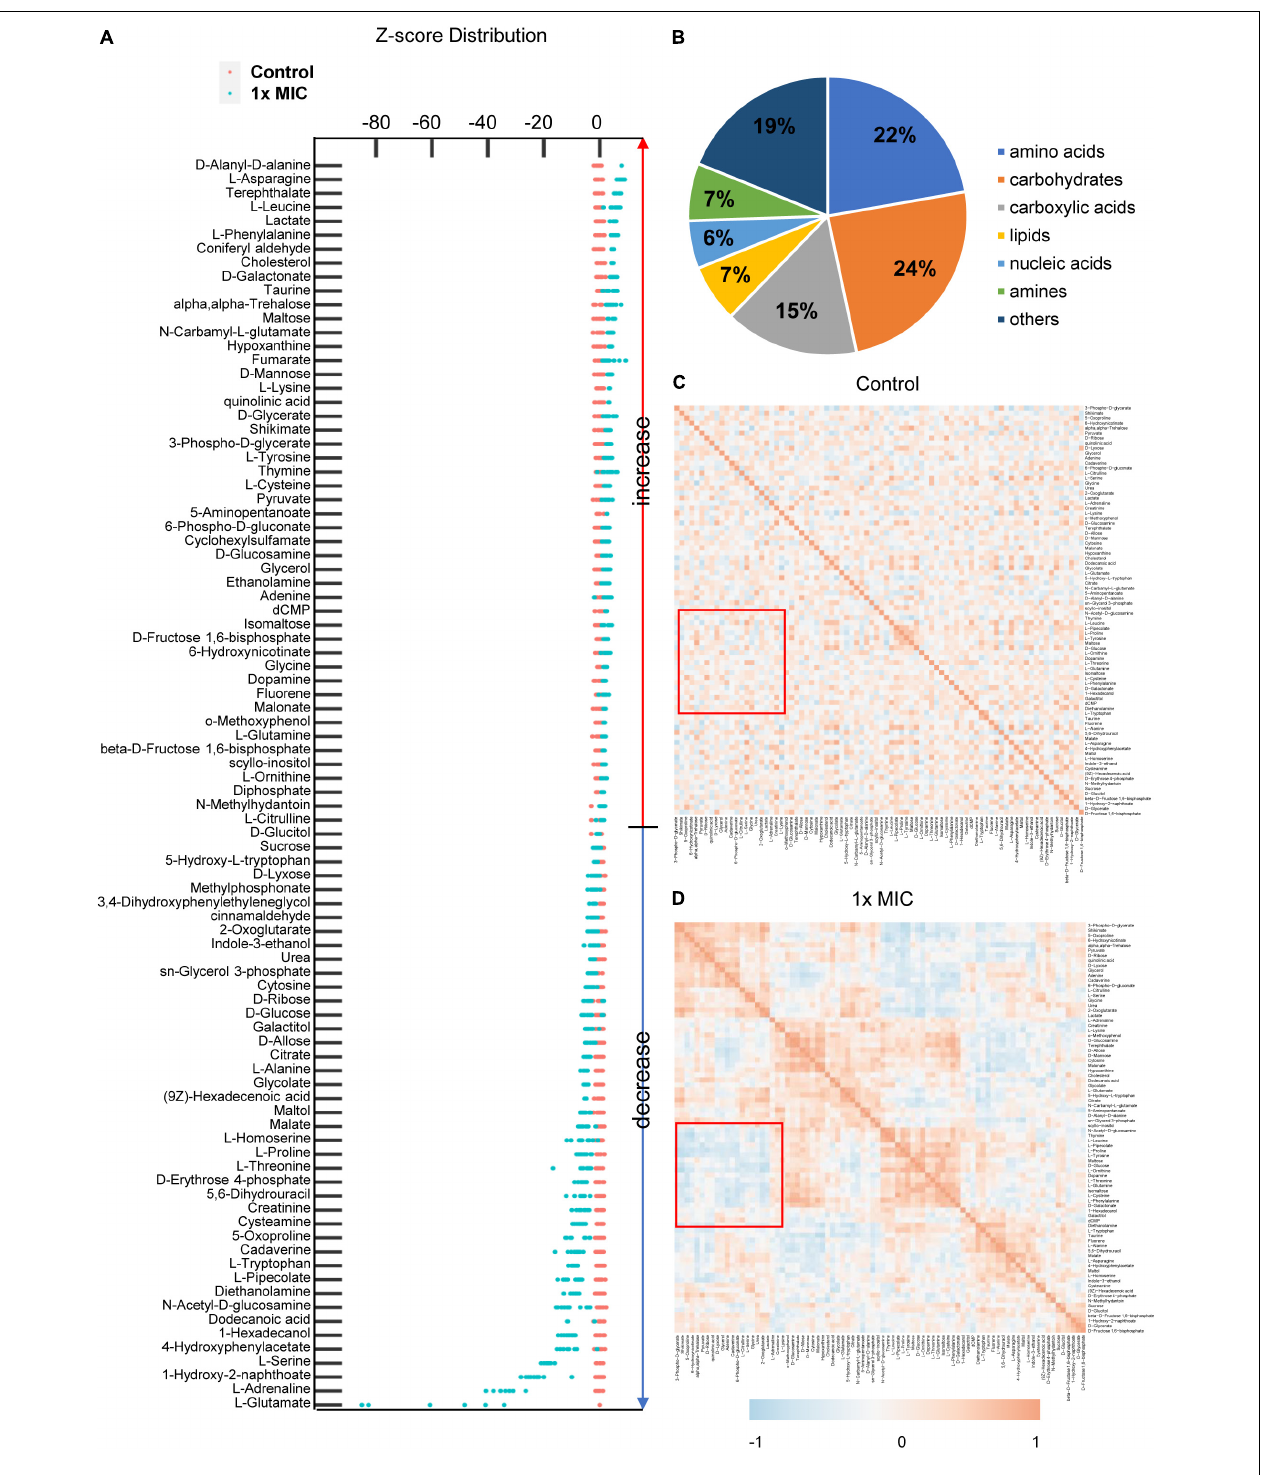
FIGURE 4 | MCA induced remarkable alterations of metabolic profile in MRSE. (A) z-score distribution of the control and the MIC group. The peak areas of identified differential metabolites were normalized by the ribitol, and the z-score of each metabolite was calculated based on the mean and standard deviation of the control group. The classification of differential metabolites is shown in panel (B) , and the correlations of differential metabolites in the control and MIC groups are plotted in panel (C) . The difference of correlation between saccharide and amino acid metabolism is highlighted with the red square. The correlations of differential metabolites in the control and MIC groups were calculated from six independent experiments by Pearson’s correlation function. The heatmap of correlation and z-score plot were calculated and plotted with R statistical computing environment.